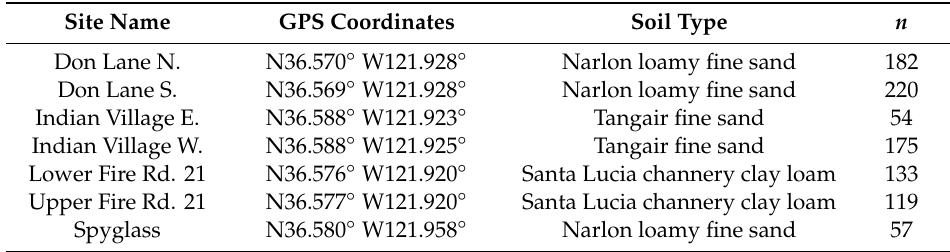
Table 1. Summary of site names, locations, soil types and numbers of Pinus radiata individuals ( n ) for seven sites in a native P. radiata forest where demographic data were